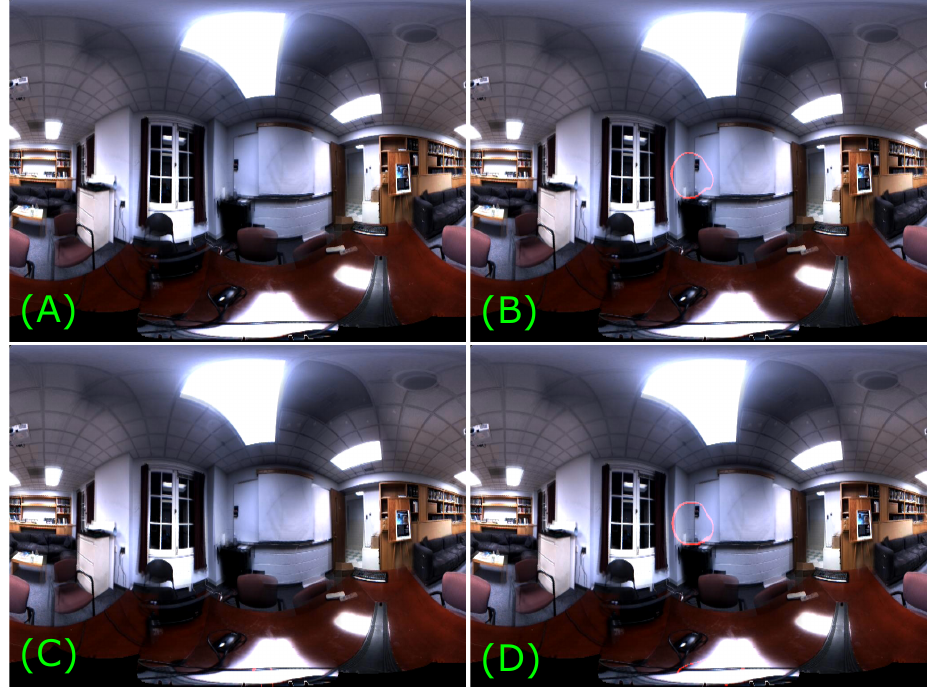
Figure 11. Comparison of AVSM with unisensory saliency maps. ( A ) Input Frame #346 of Dataset 2. The most prominent event in the scene is the audio from the loudspeaker. ( B ) The audio event is salient in ASM . ( C ) VSM in this case would be equivalent to a static saliency map, hence the auditory salient event is missed here. ( D ) AVSM 1 also captures the audio as the most salient as